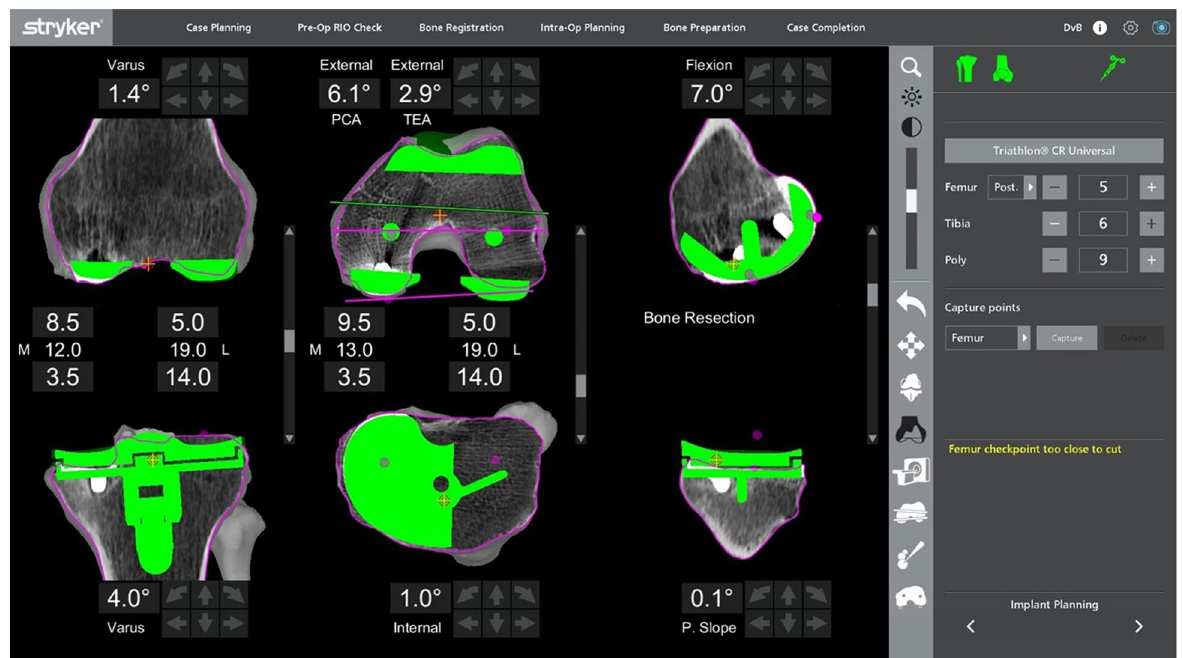
Fig. 11 The non‑mechanically‑aligned knee plan for the same patient in Fig.